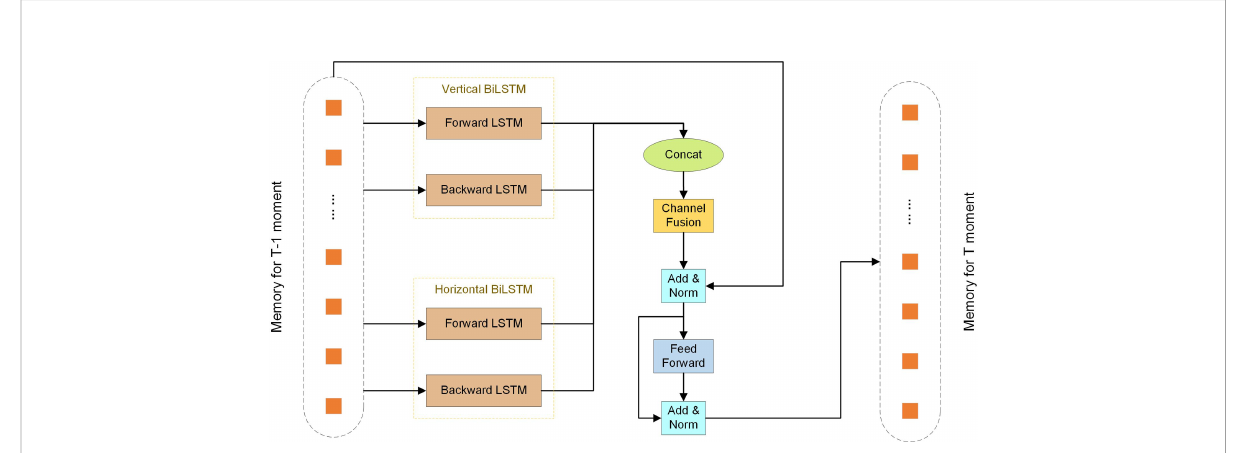
FIGURE 2 The memory aggregation module